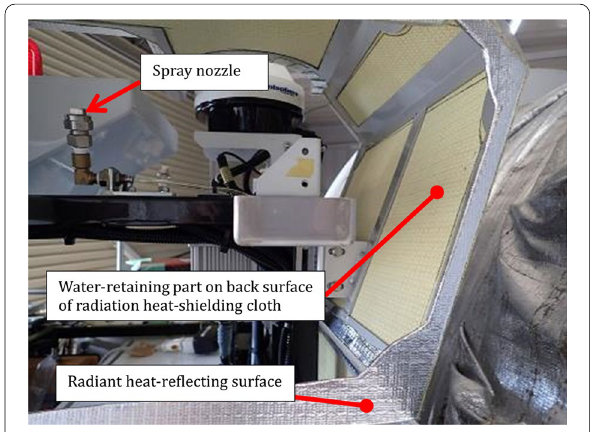
Fig. 16 Radiant heat-resistant exterior cover seen from inside the